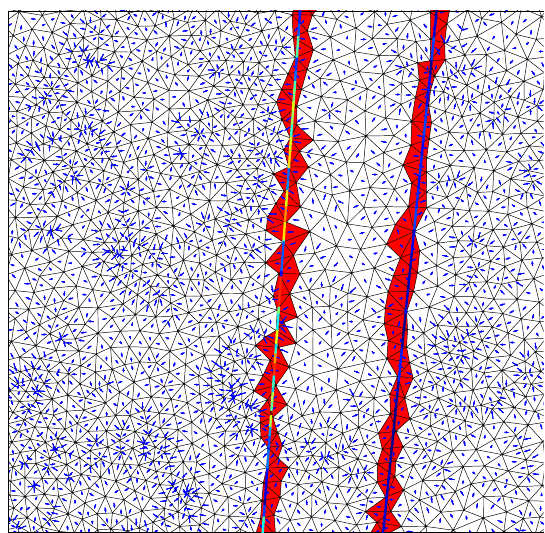
Figure 23 . The same as figure 20 but for the dataset with ρ = 1 . 5 shown in the right panel in figure 21. In addition to the line C w with the largest value of the wombling measure ¯Γ , for comparison we also show a generic line with a more typical value of ¯Γ[ C ] ; for concreteness, we chose the line at ( p in , p out ) = (0 . 7 , 0 . 8) which happens to have ¯Γ[ C ] = 0 . 08